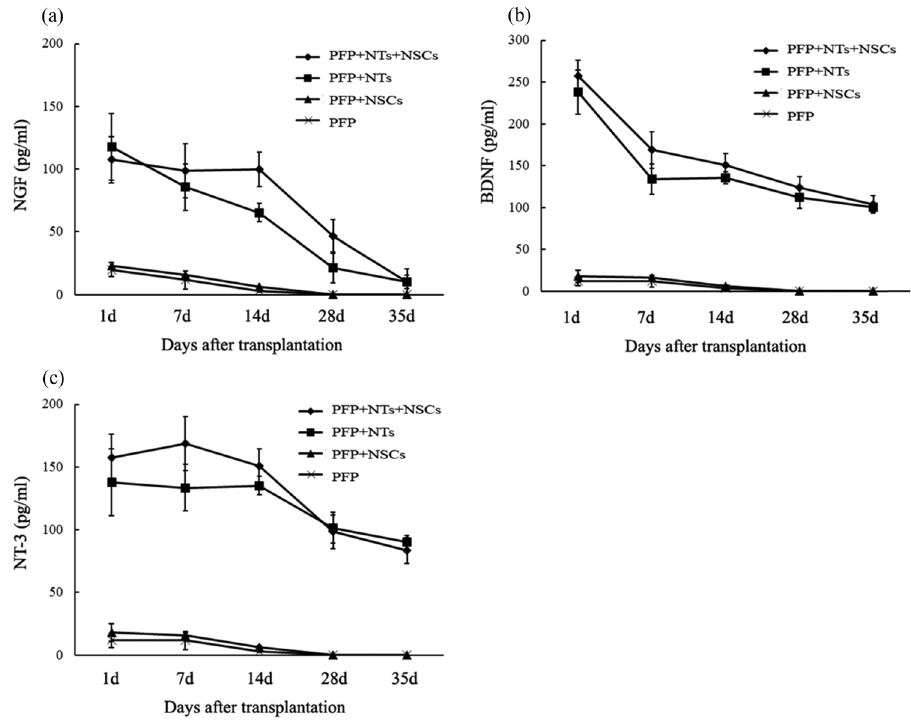
Figure 2: Three neurotrophic factor levels in ischemic penumbra of model rats. ( a ) NGF ( b ) BDNF, and ( c ) NT - 3 levels were examined by ELISA assay. The results are shown as the mean value ± SD ( n = 3 )